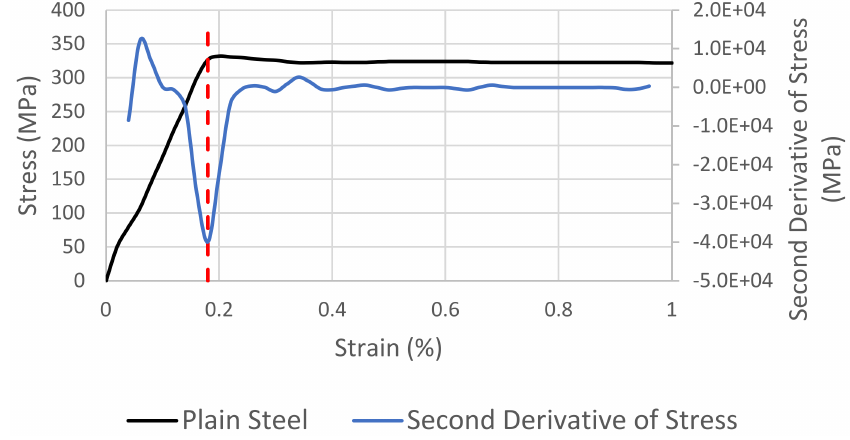
Figure 8. Derivative yield as applied to an experimentally measured stress–strain curve for plain steel subjected to tensile loading.